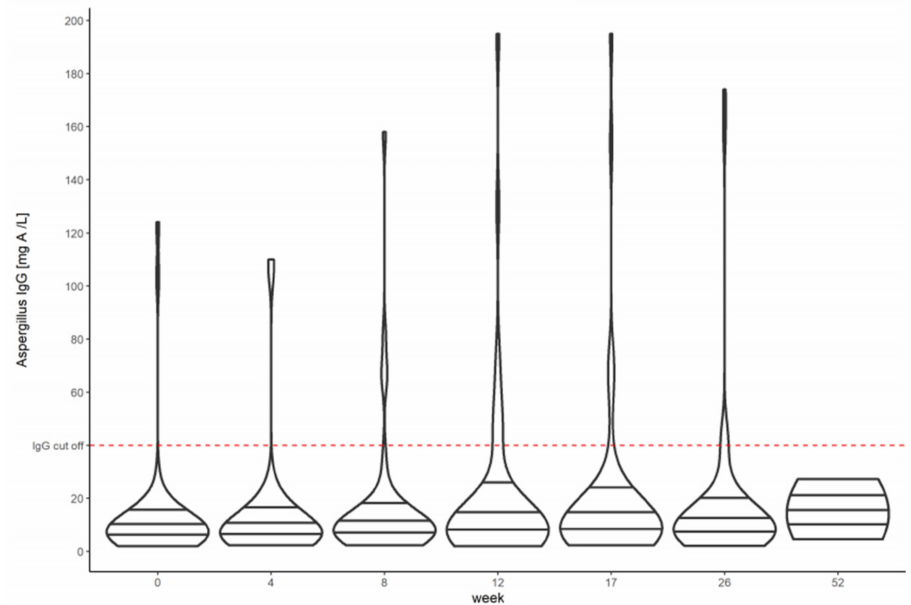
Figure 1. Violin plots showing the Aspergillus -specific IgG antibody levels before, during, and after tuberculosis treatment in HIV-positive and HIV-negative Mozambican patients with pulmonary tu-